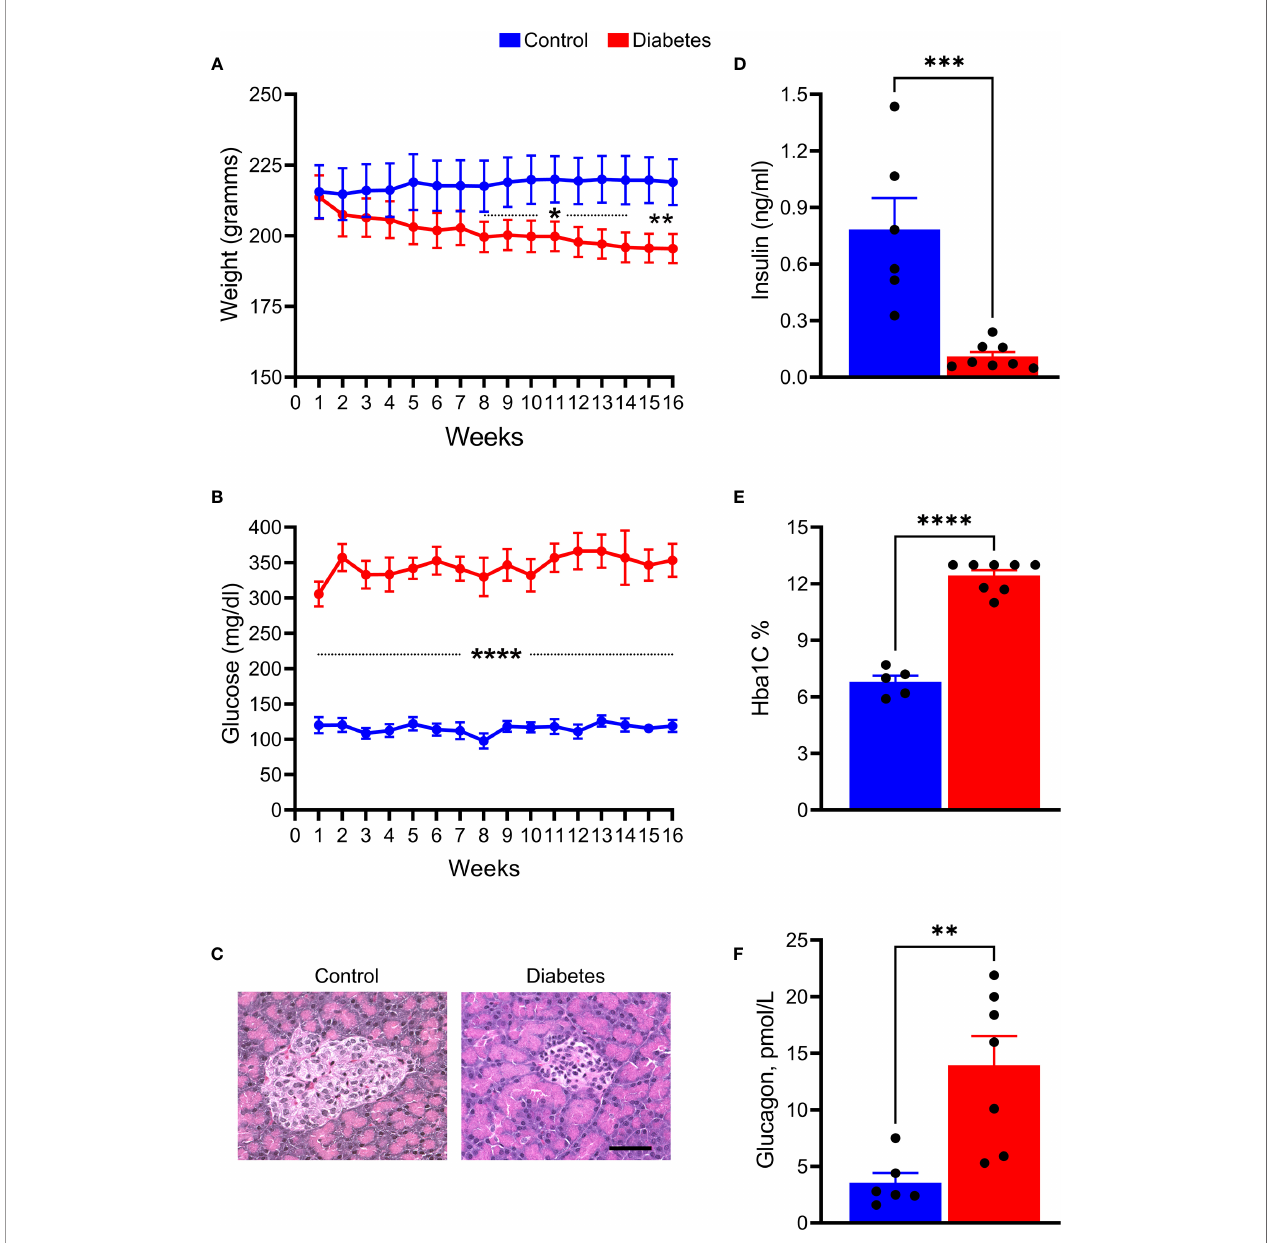
FIGURE 1 | STZ injection results in the development and progression of T1D diabetes in tree shrews . (A) The body weight was reduced in diabetic tree shrews, starting at 8 weeks after injection. (B) At 1 week after the STZ injection, the blood glucose levels were signi fi cantly and consistently upregulated > 300 mg/ml in diabetic animals as compared with control tree shrews. (C) The islet b cells were almost lost in the pancreas of diabetic animals as a result of STZ injection leading to diminished insulin production measured in the serum of diabetic and control animals (D, E) The HbA1c levels measured at the end of the experimental protocol were markedly increased in diabetic tree shrews compared with control animals, suggesting sustained hyperglycemia after injection with STZ. (F) Both the reduction in insulin production and the increase in HbA1C were in agreement with elevated glucagon level in the serum of diabetic tree shrews (n=xx). * p < 0.05, ** p < 0.01, *** p < 0.001, **** p < 0.000, n=